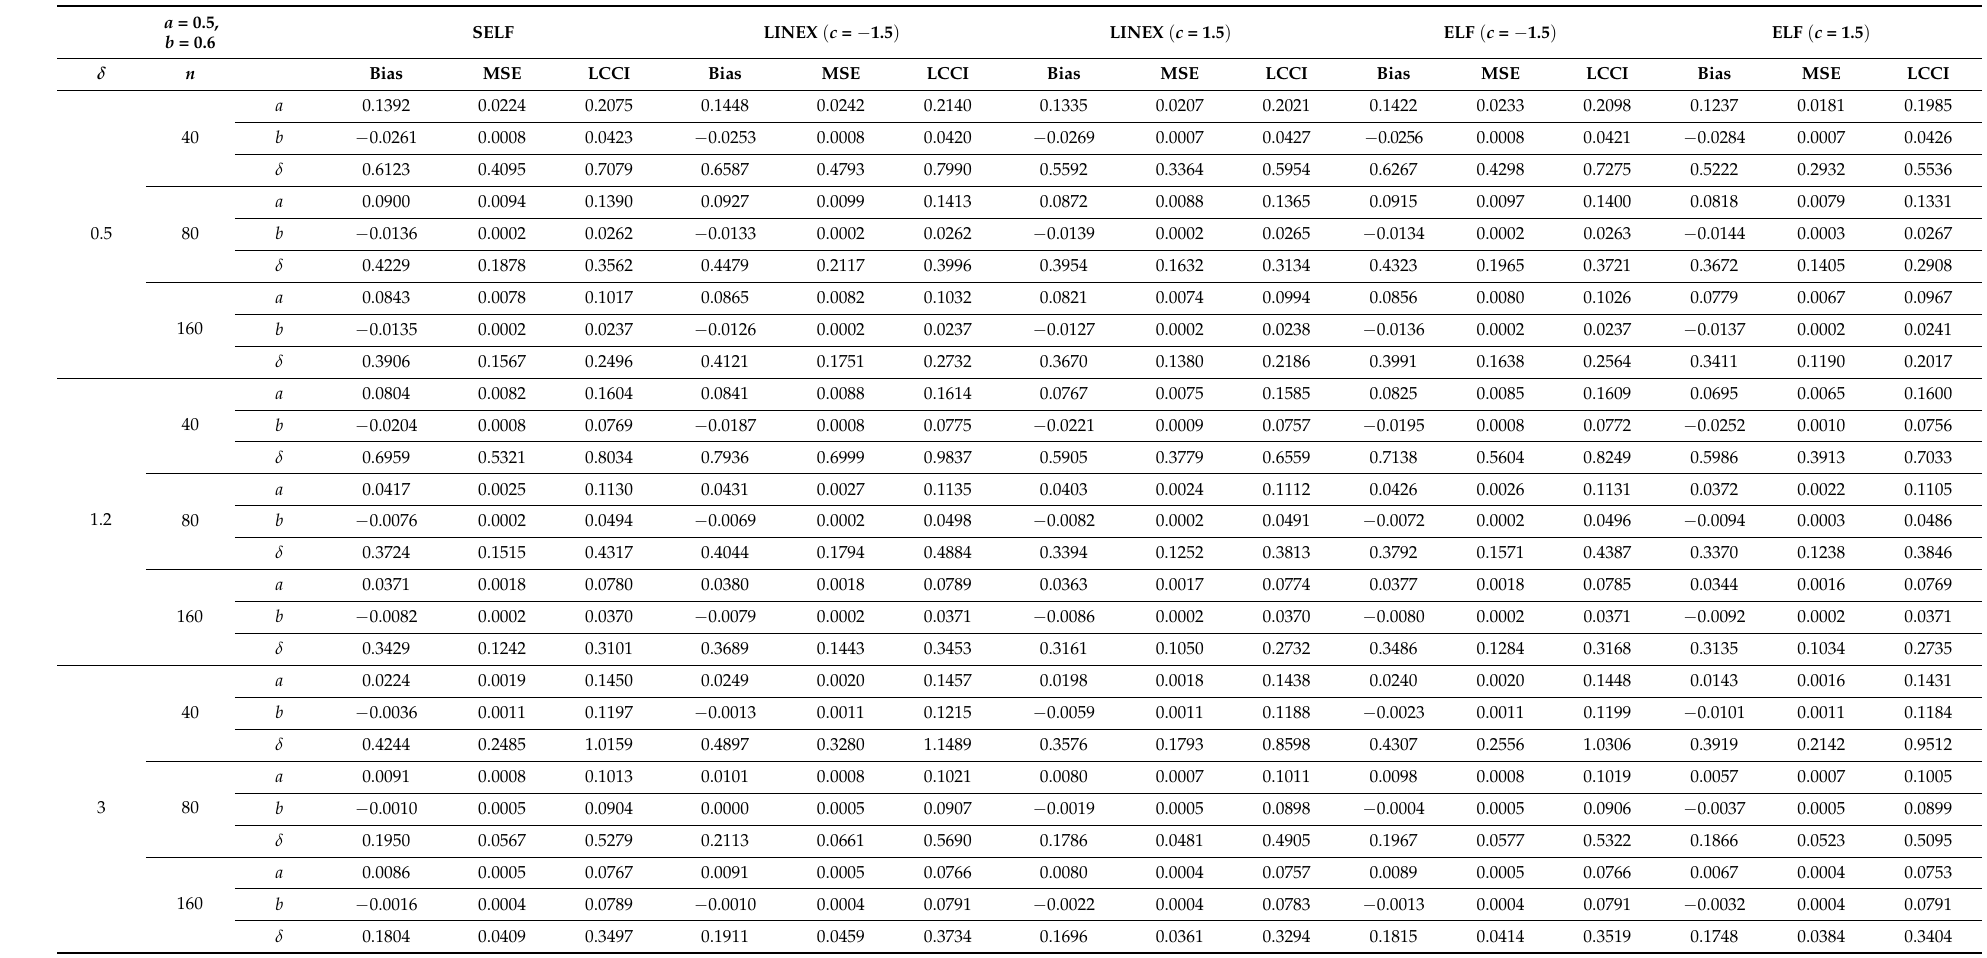
Table 3. Bayesian inference with different loss functions when a = 0.5, b =